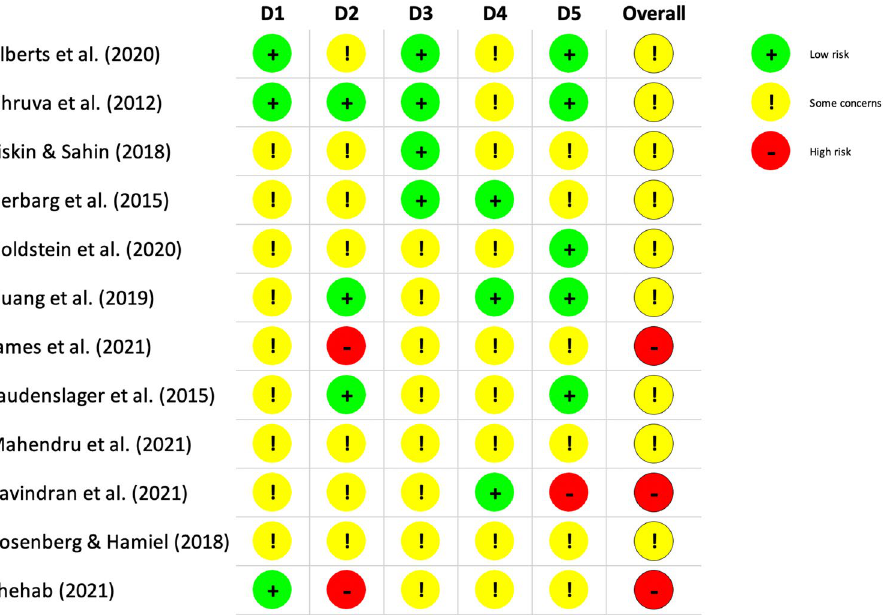
Figure 2. Risk of bias scoring using Cochrane Collaboration’s RoB 2 tool. Green and red colours correspond to low and high risk of bias, respectively. Yellow represents some concerns. D1 Randomisation process, D2 Deviations from the intended interventions, D3 Missing outcome data, D4 Measurement of the outcome, D5 Selection of the reported result.